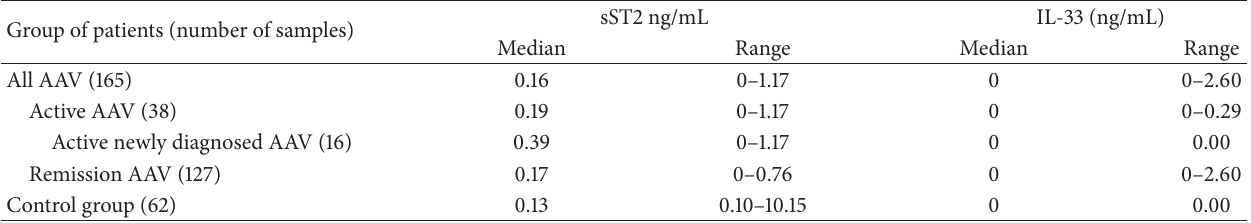
Table 3: Ranges and medians of sST2 levels and IL-33 levels in AAV patients.